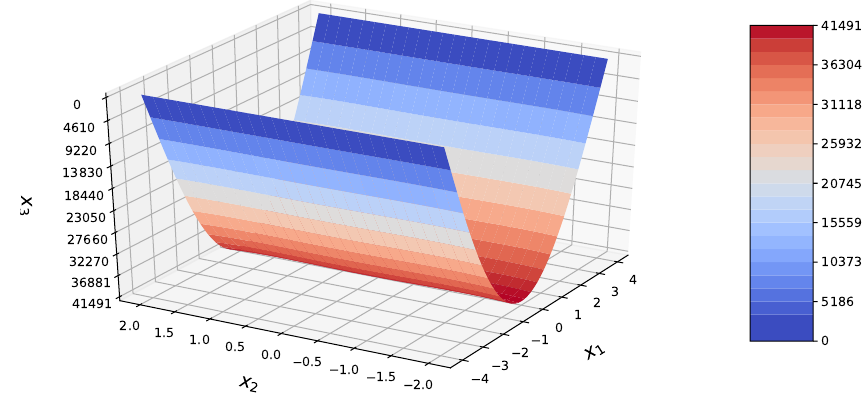
Figure 5. Three-dimensional plot of the bending moment M 11 of a rectangular plate with two opposite edges simply supported and the other